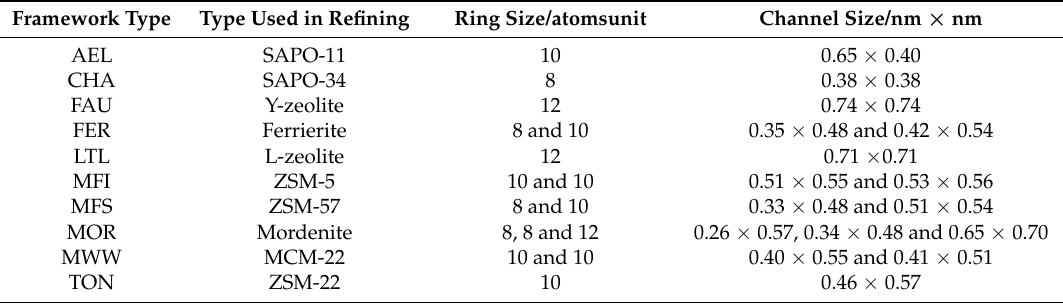
Table 1. Zeolite framework types and properties relevant to fuels refining processes.